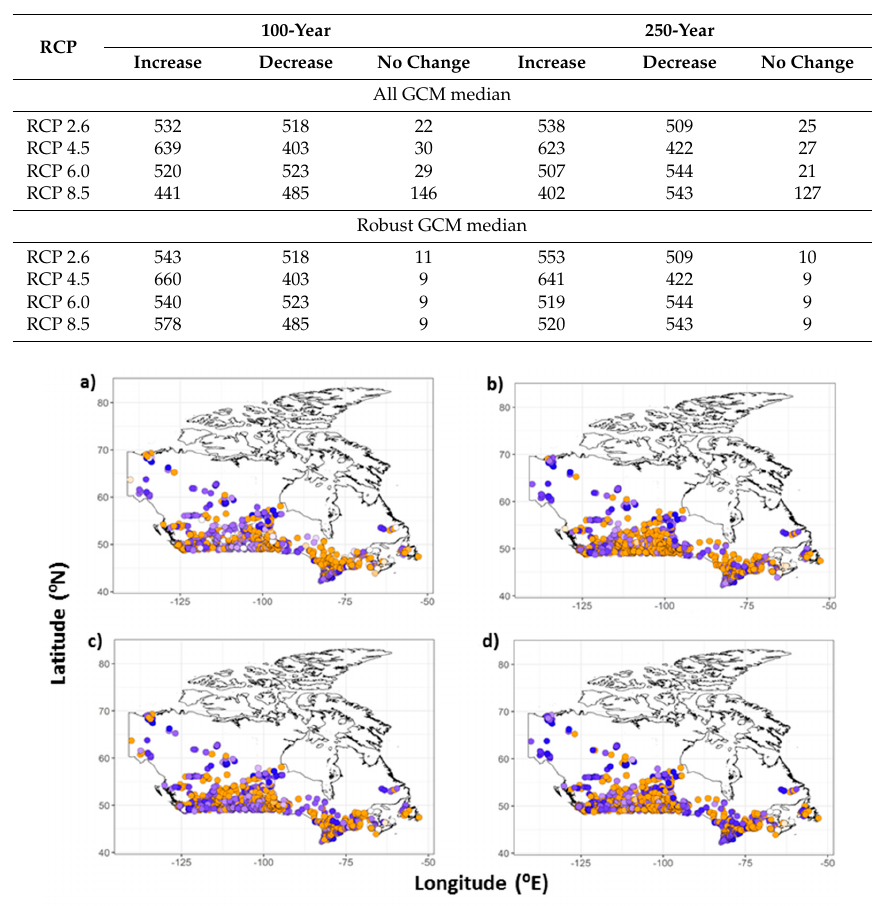
Table 6. Sign of change in flooding frequencies projected for FRIs in Canada.